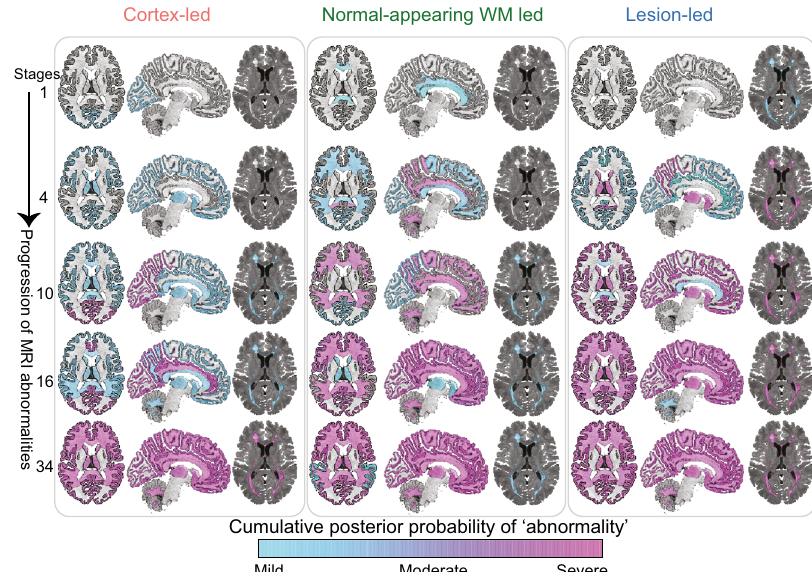
Fig. 1 MRI-based subtypes. the evolution of MRI abnormalities in each of the three MRI-based subtypes. The colour shade ranges from blue to pink which represents the probability of abnormality (it can be interpreted as the degree of abnormality) (mild, moderate or severe which approximates 1, 2 and 3 sigma). The cortex-led subtype (left) showed cortical atrophy in the occipital, parietal and frontal cortex in the early stages of the sequences, and a reduction in T1/T2 ratio in the NAWM in the later stages. The normal-appearing white matter (NAWM)-led subtype (middle) showed a reduction in T1/ T2 ratio of the cingulate bundle and corpus callosum in the earlier stages of the sequence, and deep grey matter and temporal grey matter atrophy in the later stages. The lesion-led subtype (right) shows early and extensive accumulation of lesions in the earlier stages of the sequence, and a reduction in the T1/T2 ratio in the NAWM in the later stages. The numbers on the left side represent SuStaIn stages. The minimum stage is 1 and the maximum stage is 39 (based on 13 variables that show mild (sigma = 1), moderate (sigma = 2) and severe abnormality (sigma = 3)). Acronyms: NAWM, normal-appearing white matter; SD, standard deviation; GM, grey matter; T1/T2, T1-T2